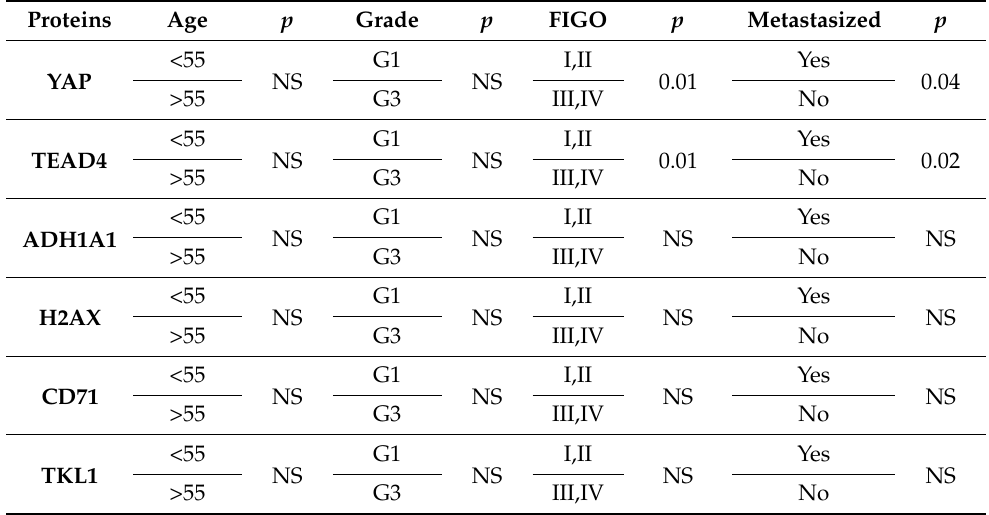
Table 6. Comparison of the tested proteins immunohistochemical expression depending on grading and staging.